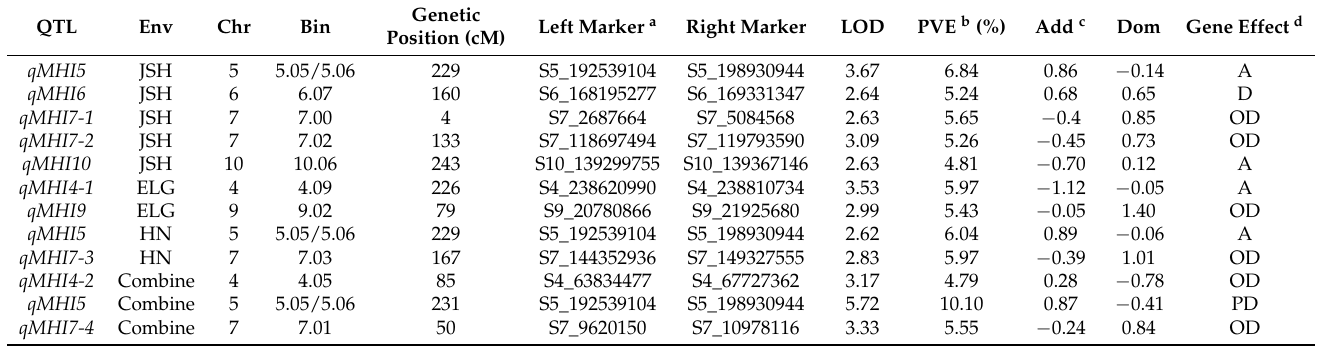
Table 4. Single environment QTL mapping of maternal inducibility in the F 2